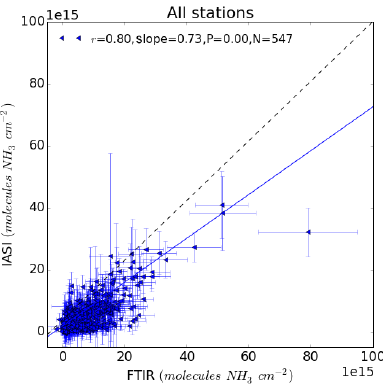
Figure 5. Correlations between the FTIR and IASI total columns with filters thermal contrast > 12K, t diff < 90min, x diff < 25km. The trend line shows the results of the regression analysis.